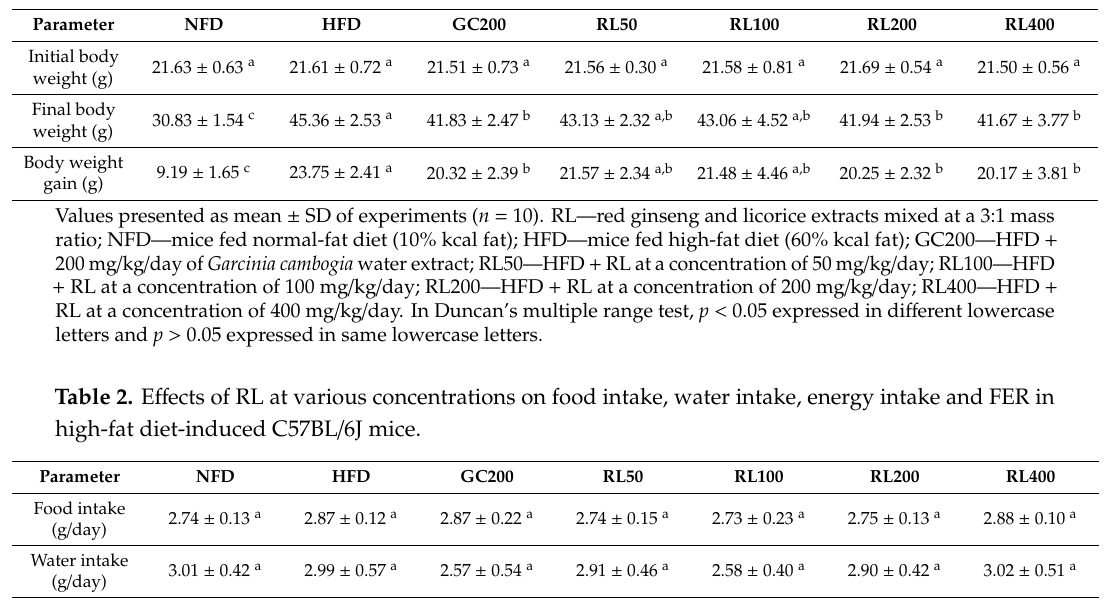
Table 1. E ff ects of RL at various concentrations on initial body weight, final body weight and body weight gain in high-fat diet-induced obese C57BL / 6J mice.